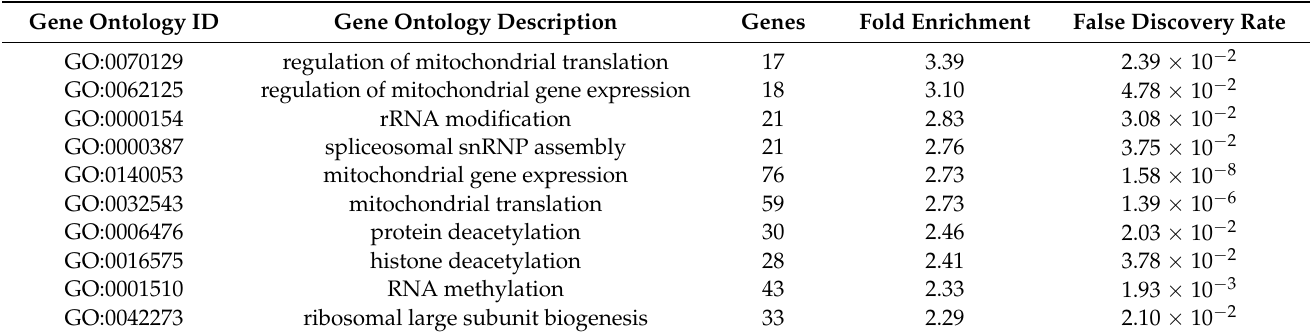
Table 2. Gene ontologies enriched for the DEGs.